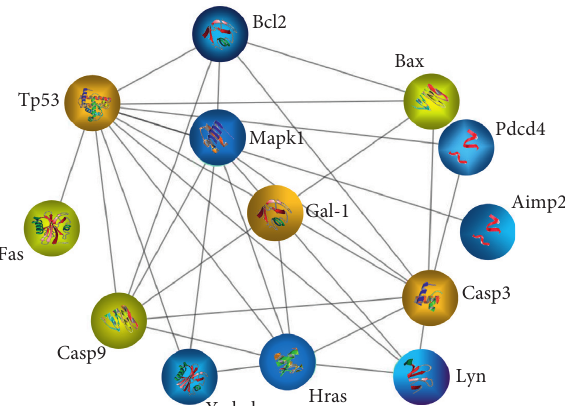
Figure 4: The PPI network of differentially expressed proteins was analyzed using the STRING database and the drawing tool Cytoscape. Yellow and blue denote high and low expressions, respectively.